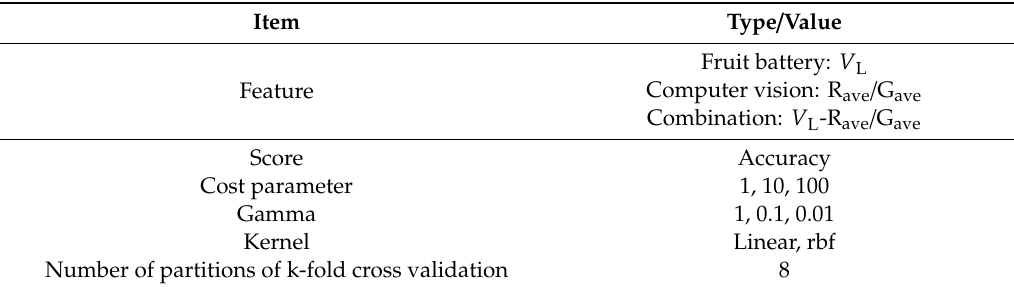
Table 3. Classification condition setting for support vector machine (SVM). Item